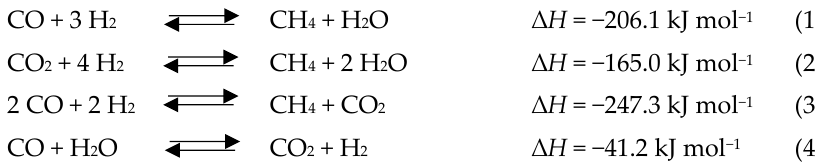
Figure 7. 6-h average CO conversion ( X CO ) and CO 2 conversion ( X CO2 ) vs . space velocity ( SV ) for Ni/Ce 0.50 Zr 0.50 O 2 in the CO x co-methanation reaction. T = 300 °C; red: CO/CO 2 /H 2 = 1/1/5; blue: CO/CO 2 /H 2 =